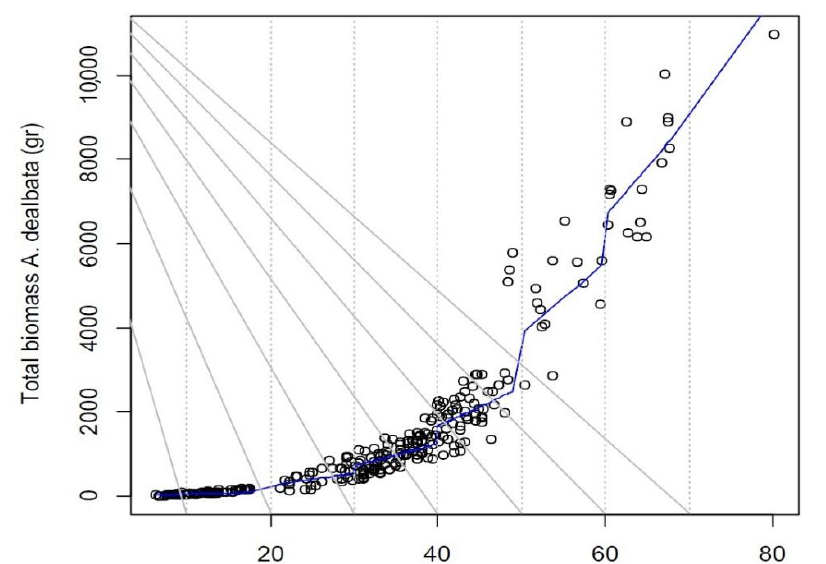
Figure 2. Adjustment of the total biomass of Acacia dealbata using the SUR method as a function of the observed values. The line represents the values adjusted by DNH intervals, considering average height and age values for each diameter class.